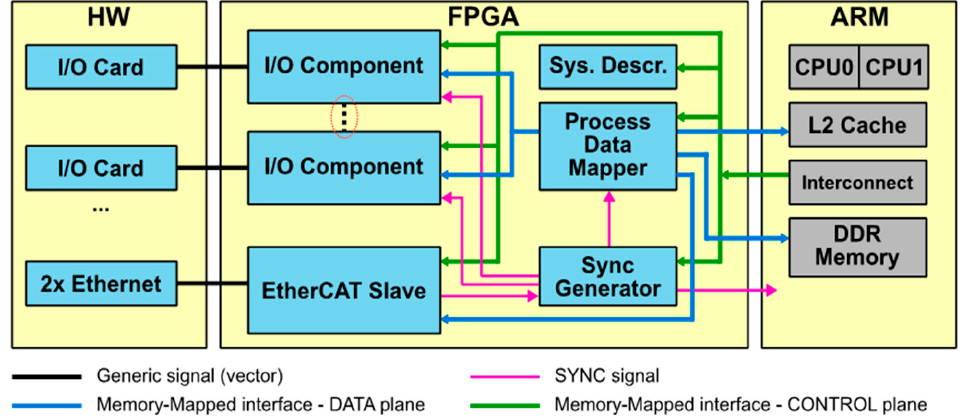
Figure 4. System structure of BB1 and interfaces to other BBs.